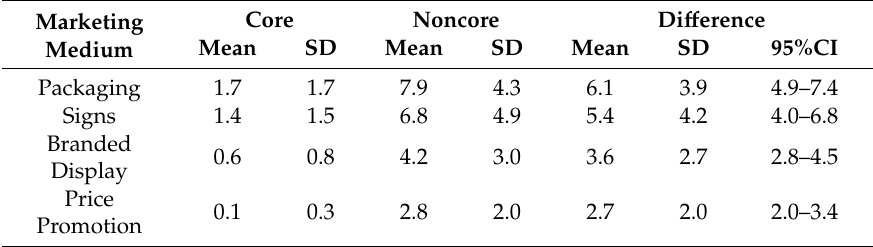
Table 3. Marketing exposure to food and drinks in convenience stores as means per child.